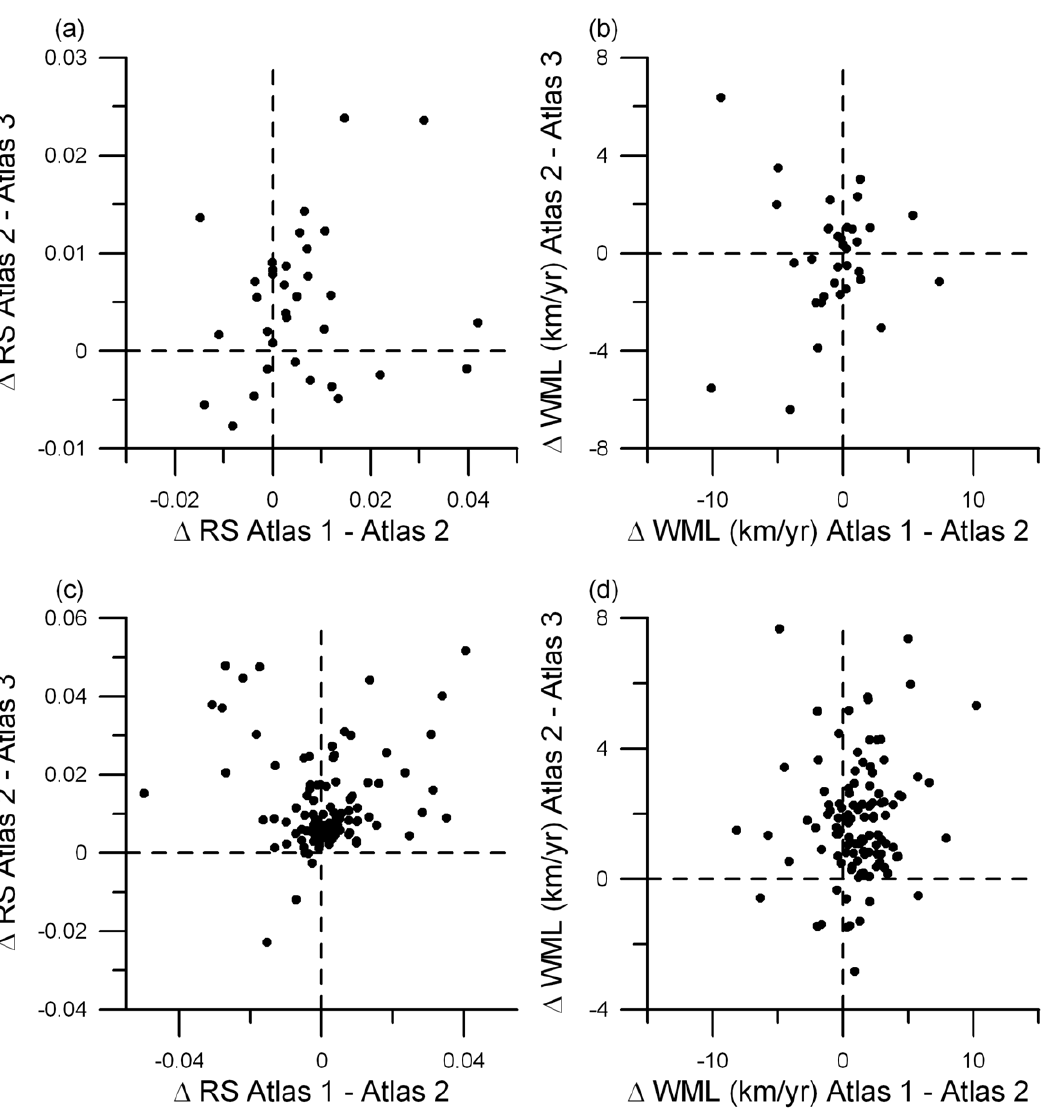
Figure 2. Analysis of the consistency of the change in range size ( D RS) and change in weighted mean latitude ( D WML) between the two study periods covered by the three atlases of Finnish breeding birds of 34 northern species (upper panels a and b) and 114 southern species (lower panels c and d). In all panels the change in the latter pair of atlases (atlas 2 vs atlas 3) is plotted against the change in the former pair of atlases (atlas 1 vs. atlas 2). The correlation between these two changes was never statistically significant (see Results).